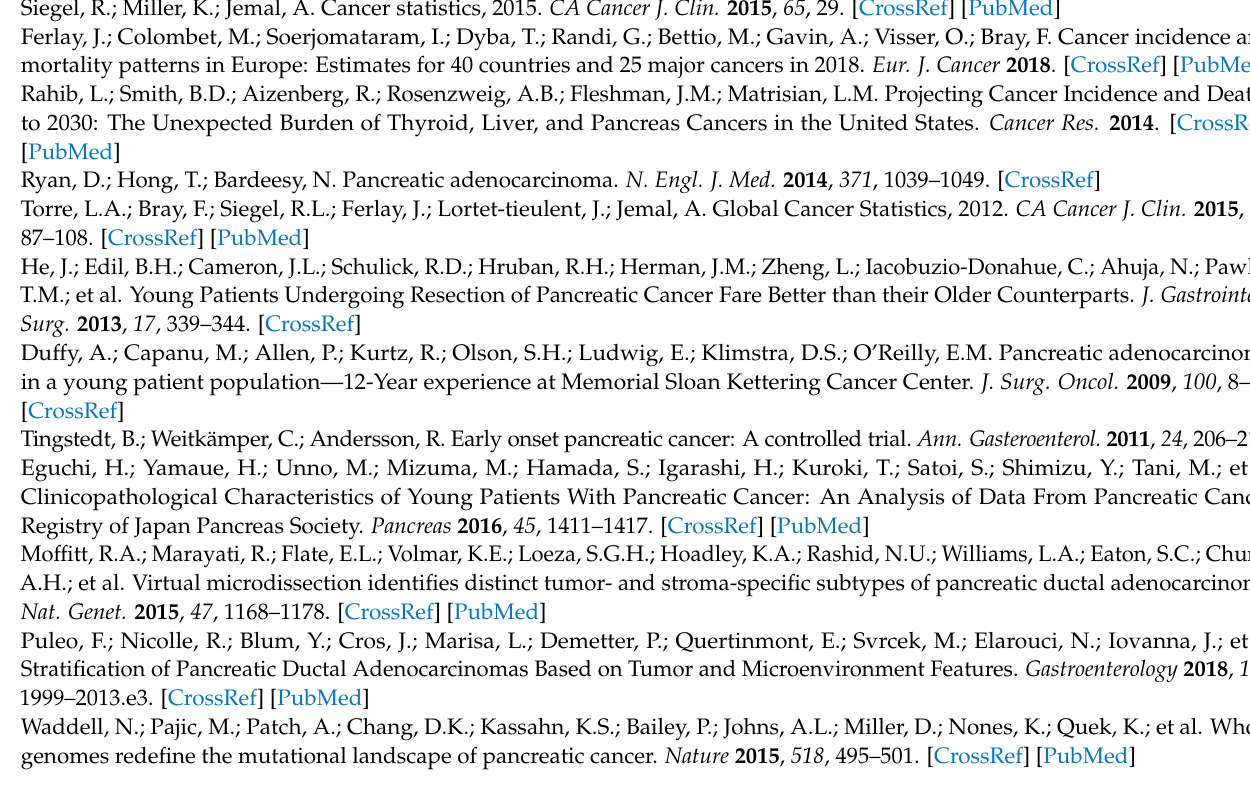
immunoblot. Table S1: Antibodies used in this study, Table S2: Clinical features of the multi-centric cohort of this study with VEOP < 45 y.o., Table S3: Clinical features of the fused TCGA_PAAD and ICGC_PAN_AU cohort of EOP < 55 y.o., Table S4: Uni- and multivariate analyses of OS and PFS of EOP and LOP from the TCGA_PAAD and ICGC_PAN_AU, Table S5: Mutational profile of KRAS , TP53 , CDKN2 A, and SMAD4 in tumoral tissues from patients in our multicentric cohort, Table S6 Clinical features of patients included in proteomic analysis by 2D-DIGE, Table S7: Identified proteins from 2D-DIGE